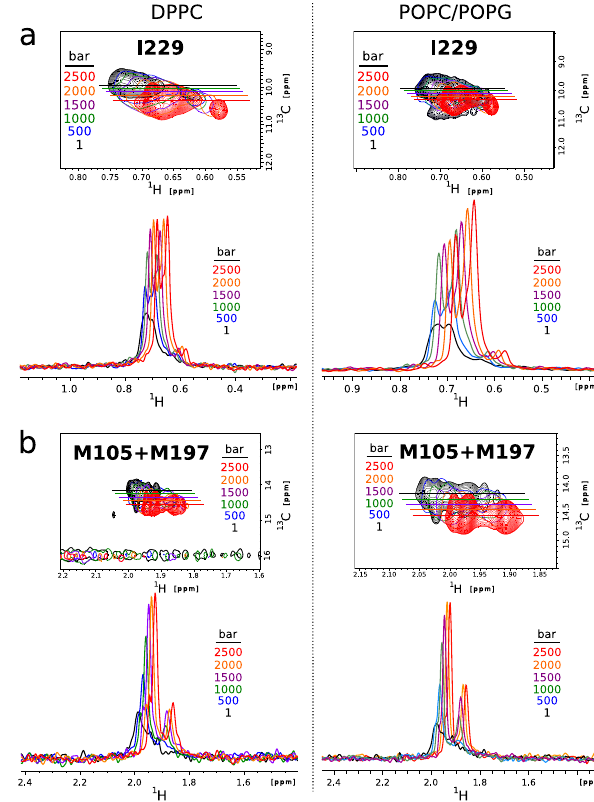
Fig. 9 Boost in receptor methyl signal intensities upon pressurization. Evolution of I229 ( a ), M105, and M197 ( b ) high-populated sub-state 13 CH 3 NMR signals along the pressure ramp of the apo receptor in DPPC (left) and POPC/POPG (right) nanodiscs. a Close-up in the δ 1 - 13 CH 3 -I229 6.40 region of six superimposed two-dimensional 1 H, 13 C-SOFAST-HMQC (950 MHz 1 H Larmor frequency) NMR spectra. For clarity, only one contour line was plotted for the experiments recorded at 500, 1000, 1500, and 2000 bar, and in the case of BLT2 in POPC/POPG nanodiscs, the low- populated states were only represented at 1 bar. b Same as a but in the ϵ - 13 CH 3.35 & M197 5.54 region. In both a and b , the horizontal dotted 3 -M105 lines indicate 13 C frequencies at which rows along the proton dimension have been extracted and represented below each 2D superimposed spectra. In the I229 region, the rows correspond to the 13 C resonance of peak 3, and in the M105 + M197 region, the rows correspond to peak B (see peak labeling in